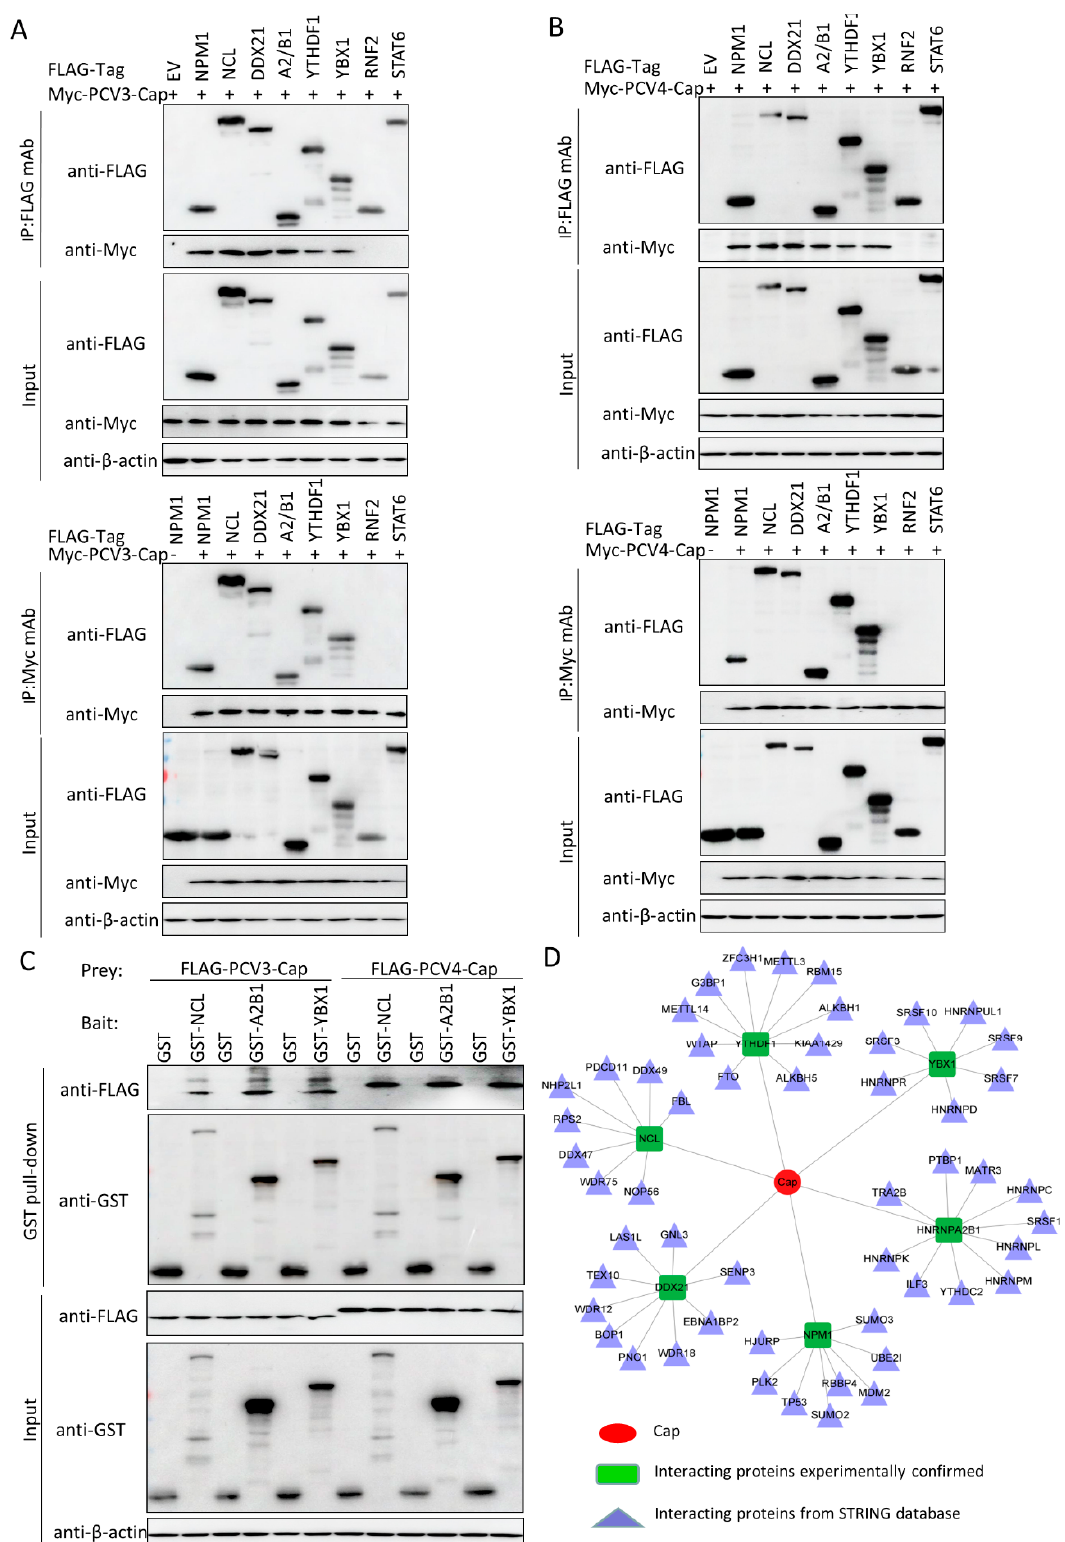
Figure 5. Validation of Cap-host protein interactions. ( A , B ) HEK293T cells were co-transfected with plasmids expressing FLAG-NPM1, FLAG-NCL, FLAG-DDX21, FLAG-hnRNPA2/B1, FLAG-YTHDF1, FLAG-YBX1, FLAG-RNF2, or FLAG-STAT6 and plasmids expressing Myc-PCV3-Cap ( A ), or Myc-PCV4-Cap ( B ), respectively. Among them, Myc-PCV3-Cap ( A ), Myc-PCV4-Cap ( B ), or FLAG-NPM1 ( A , B ) co-transfected with an empty vector served as negative controls, while Myc- PCV3-Cap ( A ) or Myc-PCV4-Cap ( B ) co-transfected with FLAG-NPM1 served as positive controls.